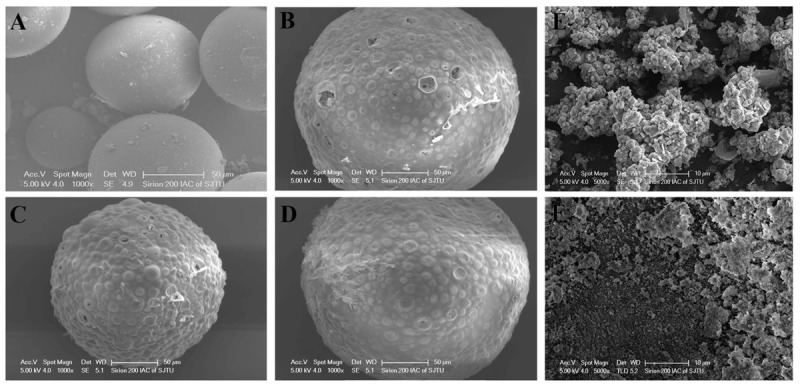
SEM images of (A) PM, (B) SR-PM, (C) SR-PM-Ag, (D) SR-PM-Ag-HA, (E) HANPs, and (F) AgNPs.